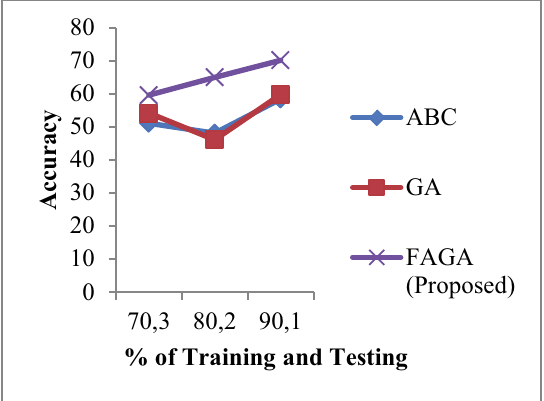
Fig.8. Accuracy using PID dataset